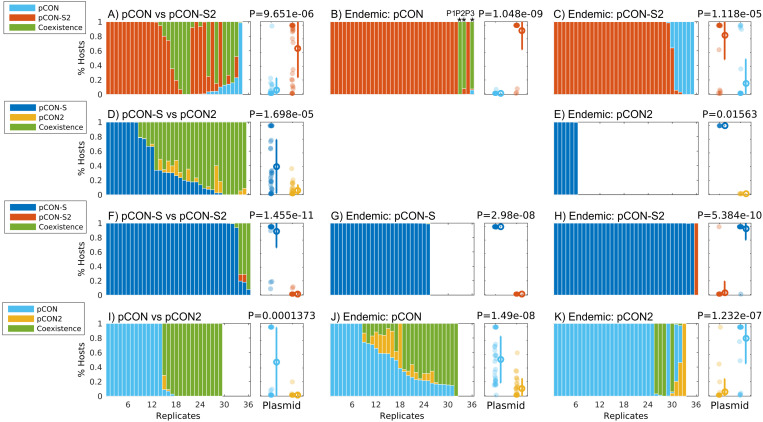
Plasmid competition experiments reveal fitness differences between competing plasmids. Plots (A–K) show the results of plasmid competition experiments. The stacked bar graphs show the results of all replicates in the competition experiment with shaded area in the bars proportional to the proportion of host types in the population (see legends). The scatter plots right of each bar graph show a comparison of the proportion of hosts of the two competing plasmids with dot color according to the plasmid type (see legend) and an error bar depicting the mean and standard deviation. The proportion of hosts was compared between the two competing plasmids using a paired sign test (Zar, 2013) with the null hypothesis H0: the frequency of the plasmid with the lower mean proportion of hosts (i.e., less frequent) is lower or equal the frequency of the plasmid with the higher mean proportion of hosts (i.e., more frequent). Replicates marked by * in (B) were further evolved in a serial transfer experiment (see Figure 4). A comparison of host composition in the evolved populations reveals no clear clustering of replicates derived from the same ancestral clone (Supplementary Figure S3), hence we consider the variability among replicates as independent of their ancestral population. Competitions where the unstable plasmid gained a majority in the population, including those depicted in subplots (A,H,K), were further analyzed by plasmid preparations of sampled colonies. The plasmid content in those replicates validated that, indeed, they were overtaken by the unstable plasmid.